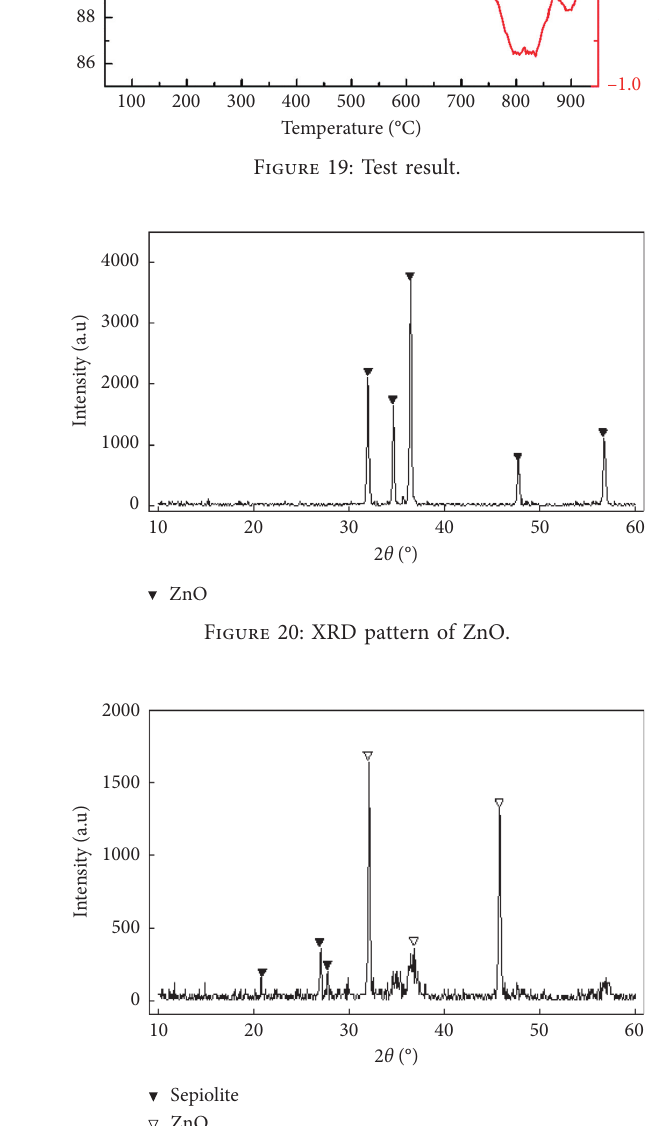
Figure 21: XRD pattern of the ZnO/sepiolite composite prepared by the sol-gel